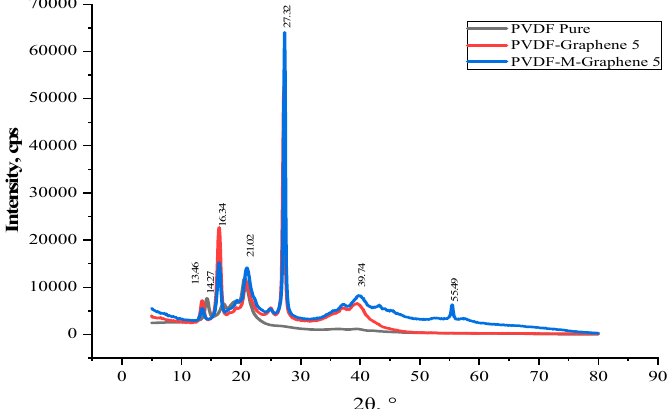
Figure 12. XRD patterns of PVDF and the unmodified and modified GNF-PVDF nanocomposites.